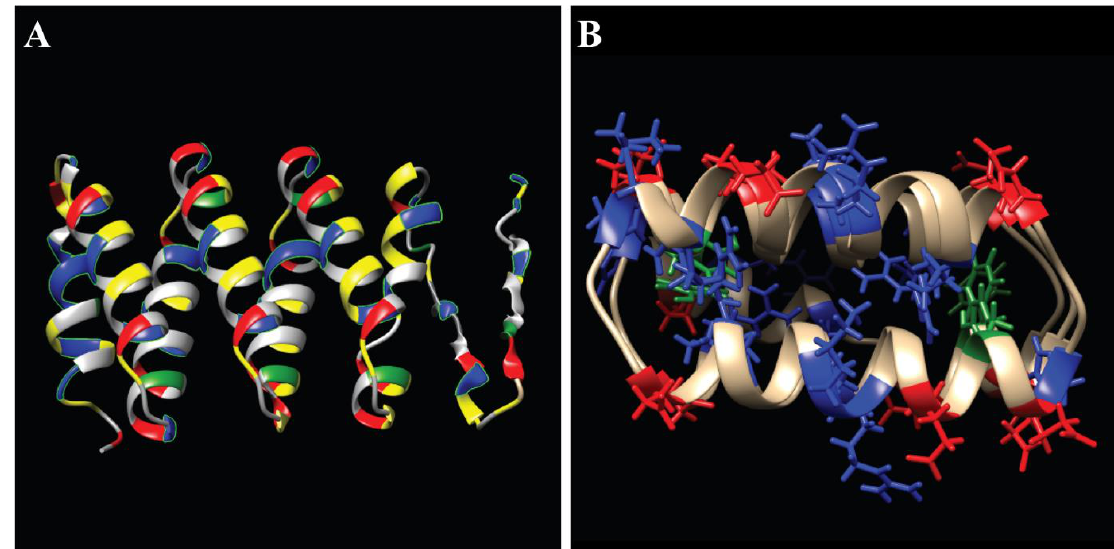
Figure 5. I-Tasser prediction of Af LEA1 structure in the desiccated state with amino acid properties labeled by color as polar (yellow), nonpolar (gray), aromatic (green), positive (red), and negative (blue). ( A ) Af LEA1 is predicted to fold into 84% α -helix, 5% β -sheet, and 11% turns. The tertiary structure of Af LEA1 is predicted to resemble a synthetic helical repeat protein (RCSB PDB ID: 5CWH) composed of helix-turn-helix structures, where each helix-turn-helix is a single Group 1 LEA motif. ( B ) The distribution of charged amino acids stabilizes the exterior of the Af LEA1. The protein’s interior is enriched with positive and aromatic residues.